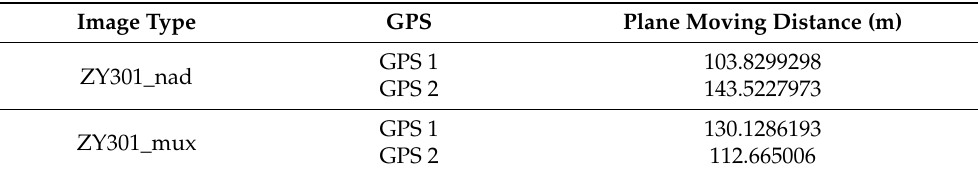
Table 5. The plane movement distance of the GPS device on the high-resolution